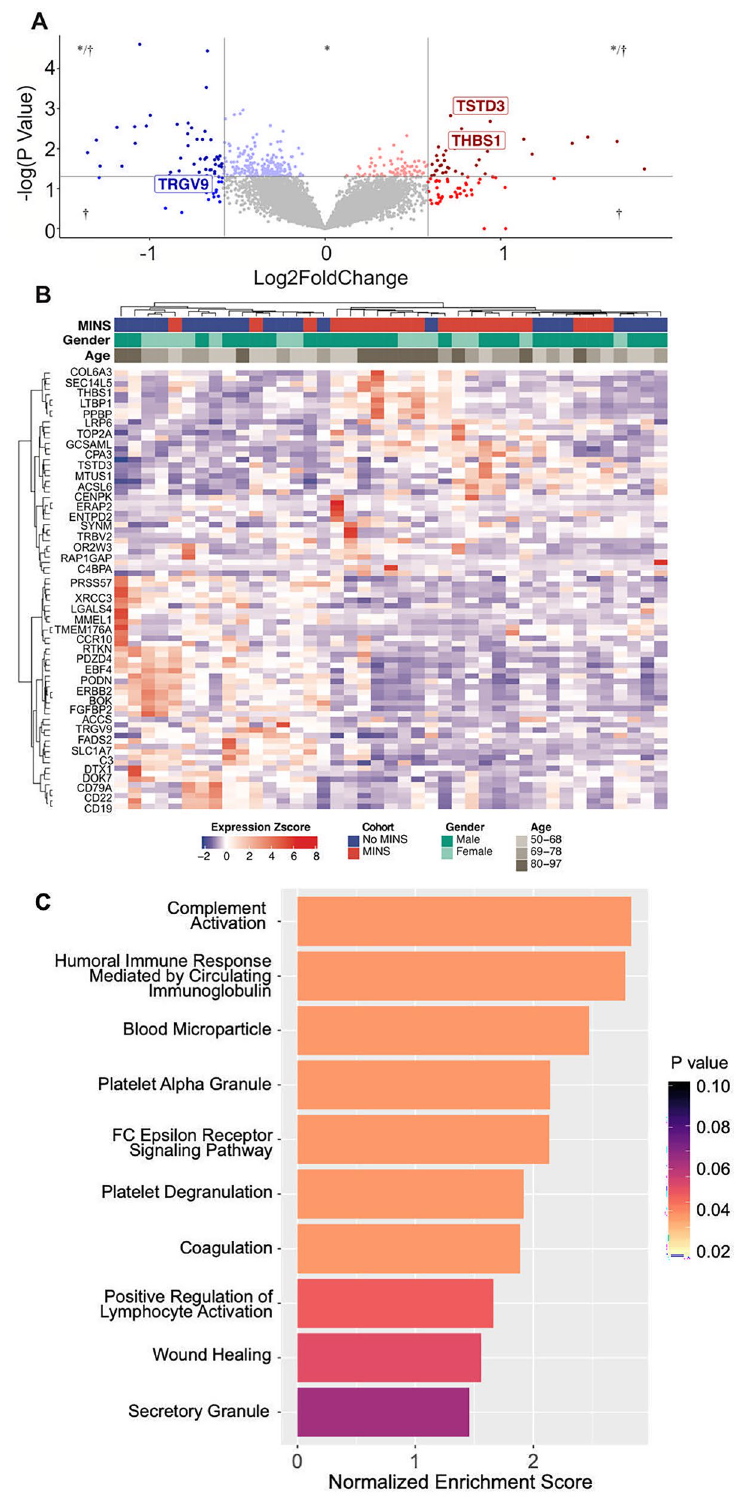
Figure 2. ( A ) Volcano plot highlighting differentially expressed genes in participants with MINS versus without MINS (n = 41), with genes of interest highlighted; * nominal p<0.01, †log2fe > 0.5. ( B ) Heat map of differentially expressed genes clustered by MINS status; ( C ) Selection of Enriched Gene Sets in patients with MINS, with Normalized Enrichment Scores for each GO term. Adjusted p values were used for the gene set enrichment analysis for all GO